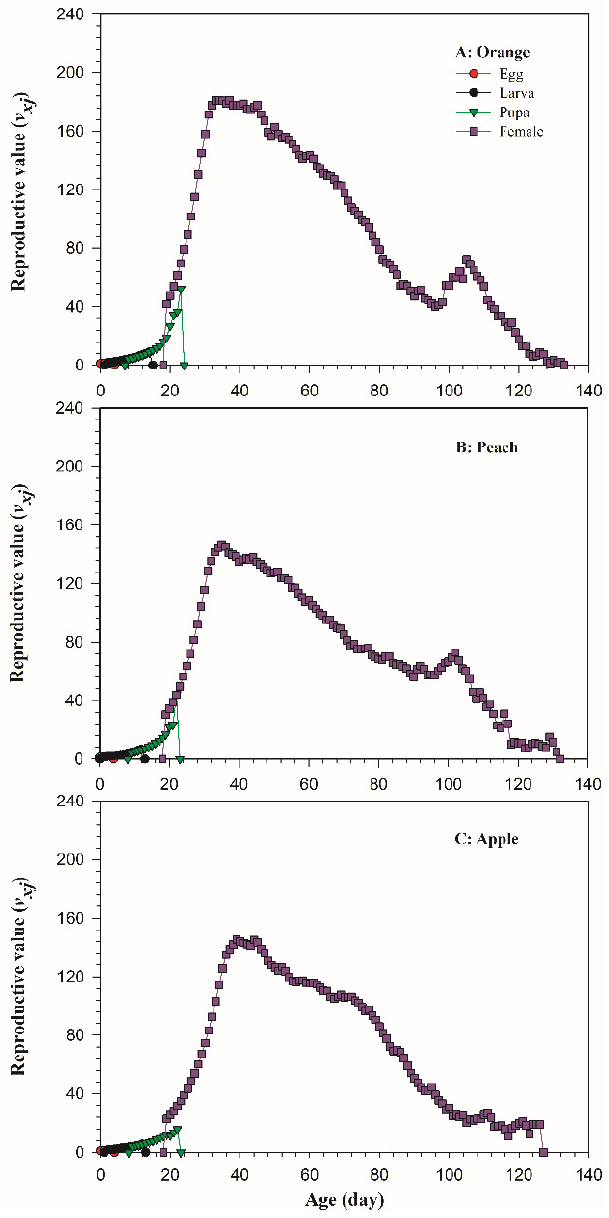
Figure 4. The reproductive value ( v xj ) of Bactrocera dorsalis on three host fruits: ( A ) orange; ( B ) peach; ( C ) apple.